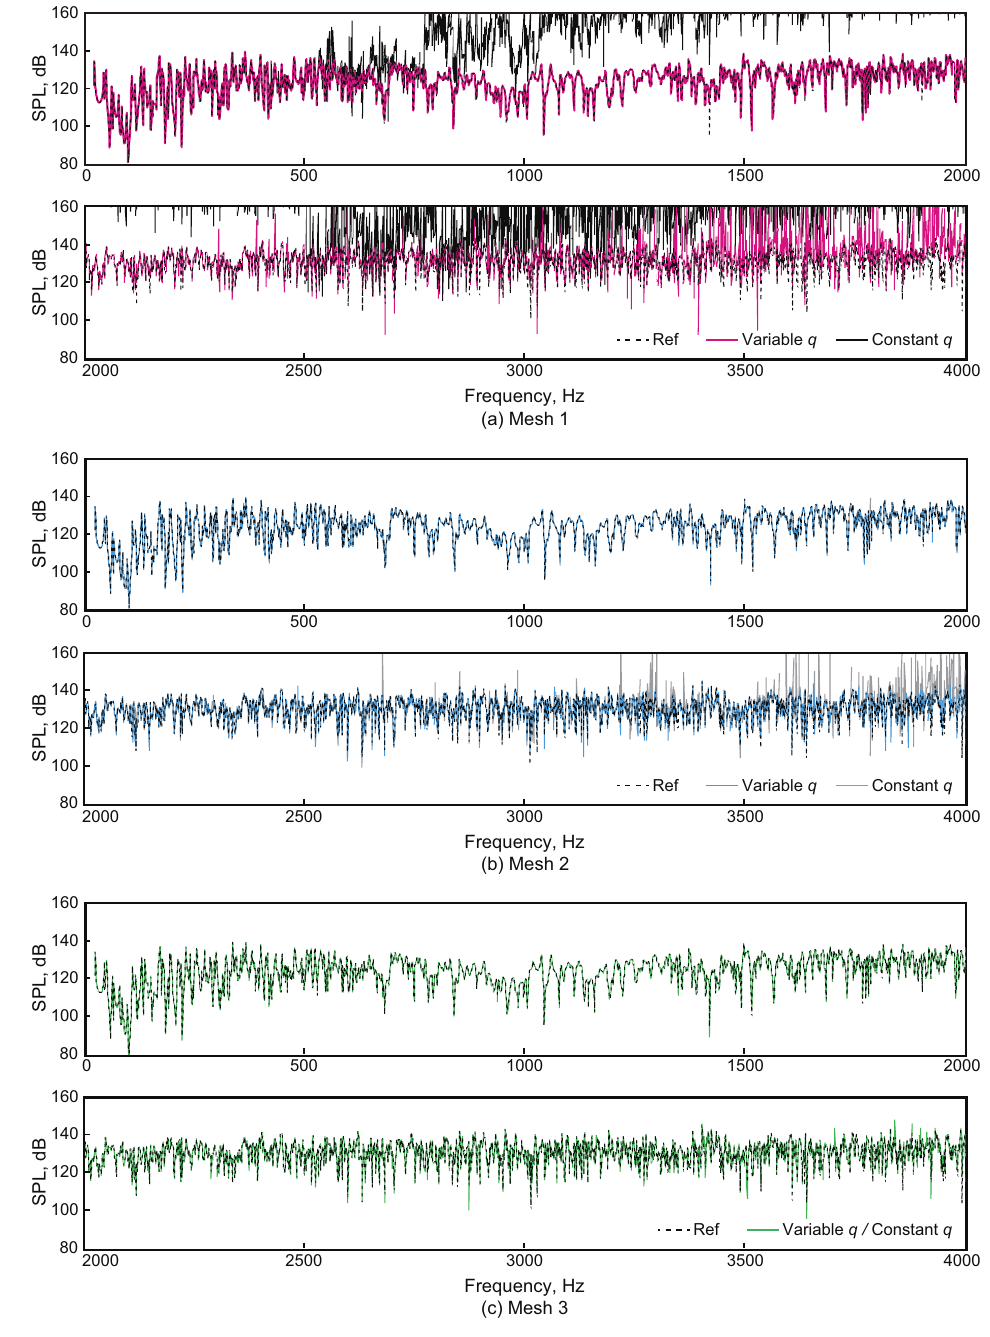
Figure 4. Comparisons of the frequency responses at R1 among the PW-FEM using the Variable q -approach and the Constant q -approach and the reference solution: ( a ) Mesh 1, ( b ) Mesh 2, and ( c ) Mesh